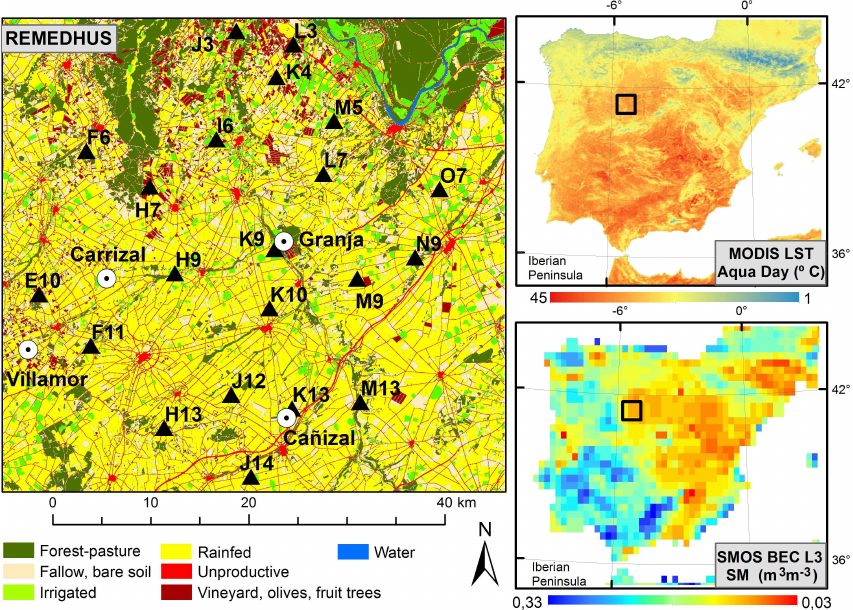
Figure 1. Land use map of the REMEDHUS network ( left ) at the river Duero basin in Spain, including the location of the 21 stations for measuring SM and LST (black triangles) and the 4 weather stations (white dartboards). Time-averaged 1-km MODIS LST Aqua day ( top right ) and 25-km SMOS BEC L3 SM ( bottom right ) maps during the study